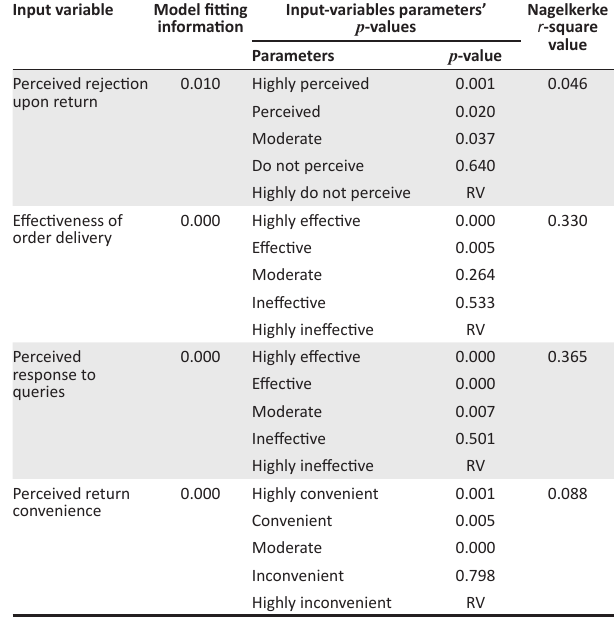
TABLE 4: Determinants of social commerce with parameters with mixed level of